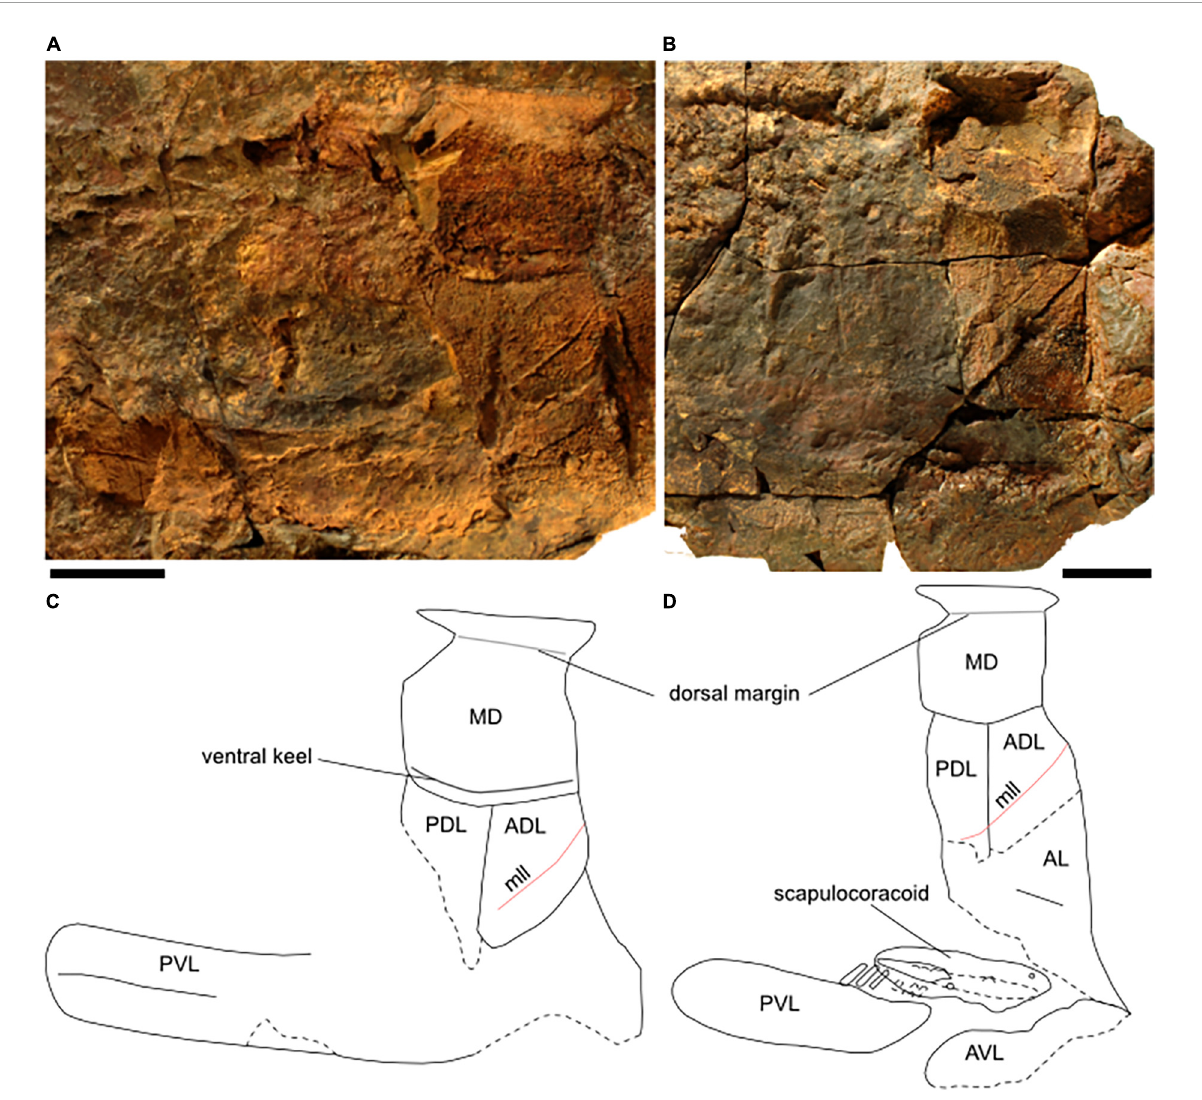
FIGURE5 Thoracic armor of Amazichthys trinajsticae gen. et sp. nov. Thoracic armor of AA.MEM.DS.8, the holotype (A) , PIMUZ A/I 4773 (B) , and their respective line drawings (C,D) . The scale bar corresponds to 50 mm. ADL, anterior dorsolateral plate; AL, anterior lateral plate; AVL, anterior ventrolateral plate; MD, median dorsal plate; PDL, posterior dorsolateral plate; PVL, posterior